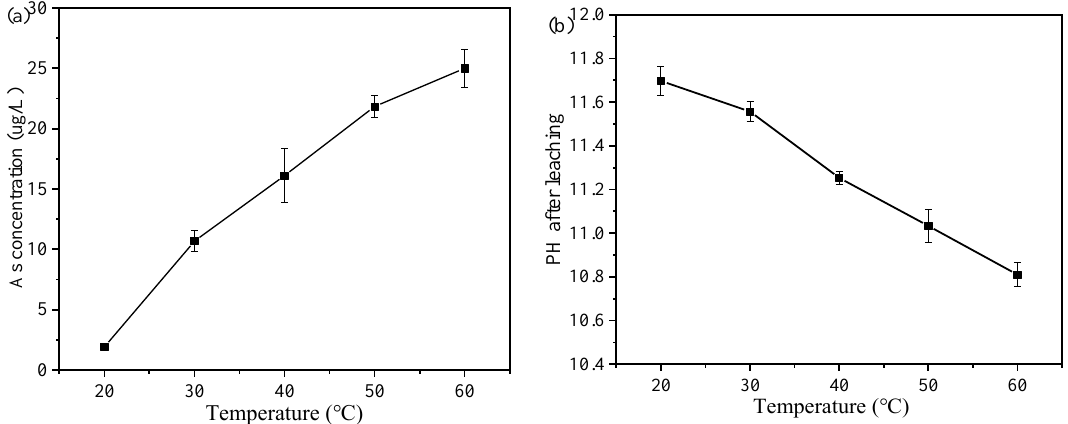
Figure 8. ( a ) The influence of different temperature on the leaching concentration of As, ( b ) the change of pH after leaching.